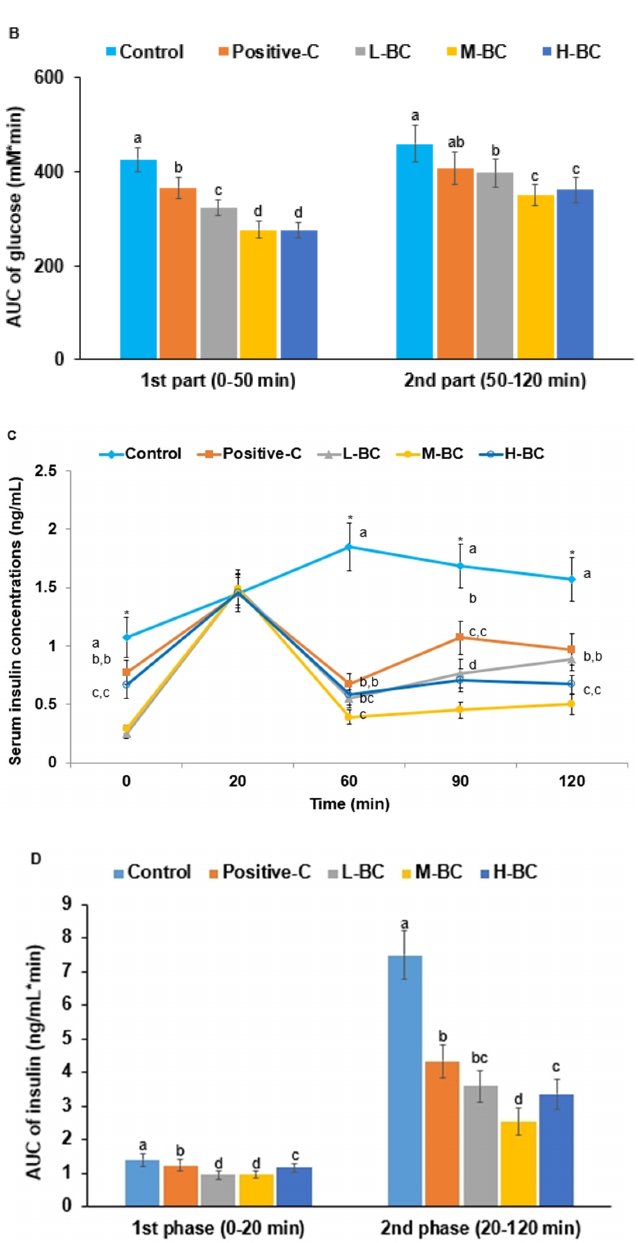
Figure 2. Serum glucose and insulin levels and areas under the curve (AUCs) of serum glucose and insulin concentrations during oral glucose tolerance testing (OGTT). Partially pancreatectomized (Px) rats were fed a high-fat diet supplemented with 0% (control), 0.2% (L-BC; low dosage), 0.6% (M-BC; medium dosage), and 1.8% (H-BC; high dosage) blackcurrant extracts; 0.2% metformin (positive-C); plus 1.8%, 1.6%, 1.2%, 0%, and 1.6% indigestible dextrin. After seven weeks of the assigned treatments, serum glucose levels were measured at 0, 10, 20, 30, 40, 50, 60, 70, 80, 90, and 120 min after fasting rats were administered 2 g of glucose/kg body weight orally ( A ). Areas under the curve for serum glucose concentrations were calculated from 0 to 50 min and 50 to 120 min during OGTT ( B ). Serum insulin concentrations were determined at 0, 20, 40, 90, and 120 min during OGTT ( C ). The AUC of serum insulin concentrations was calculated during the first 20 min and from 20 to 120 min ( D ). Dots/bars and error bars represent means and standard deviations, respectively ( n = 10). * Significantly different among the groups at p < 0.05. a,b,c,d Different letters on bars or lines indicate significant differences among the groups at p <